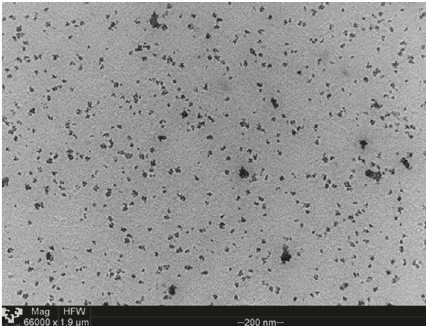
Figure 2: Micrography of particles obtained at pH of 1.75, 15 ∘ C, 0.08 g of TW80, and 1g of ECA.